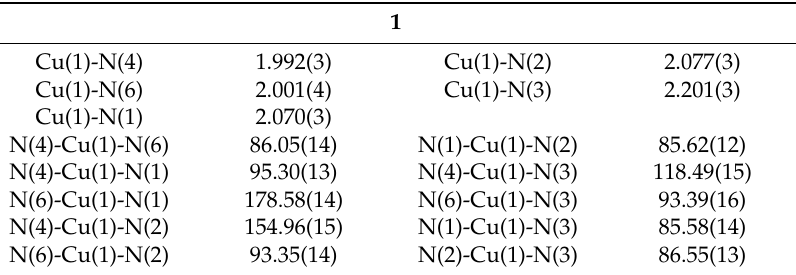
Table 2. Selected bond lengths (Å) and angles ( ◦ ) for 1 and 2